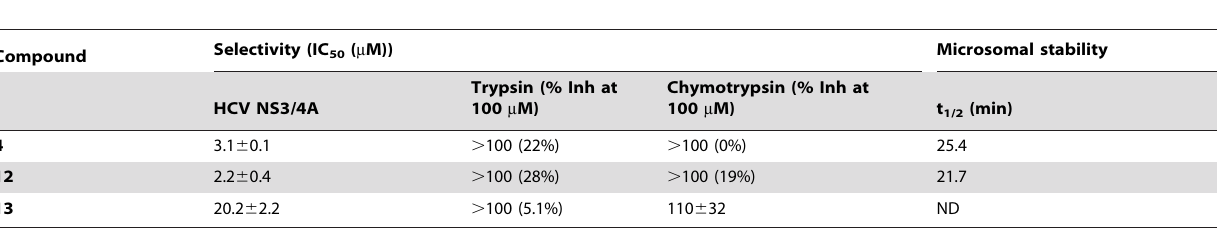
Table 3. Selectivity and microsomal stability of selected compounds.